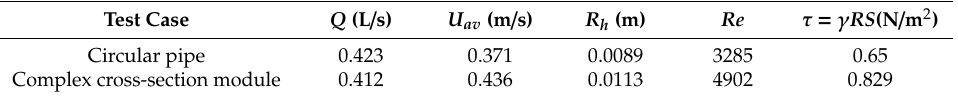
Table 4. Experimental parameters for the circular pipe and the complex cross-section module (slope: 0.01, pipe material: PVC), the discharge Q (L / s), average velocity U av (m / s), hydraulic radius R h (m), Reynolds number Re , and the average shear stress (N / m 2